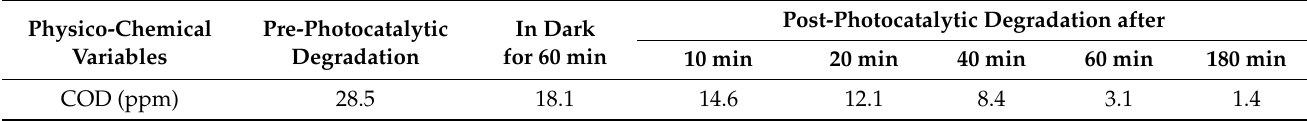
Table 3. Chemical oxygen demand (COD) changes of RhB over the Zn-TNTs at different times.